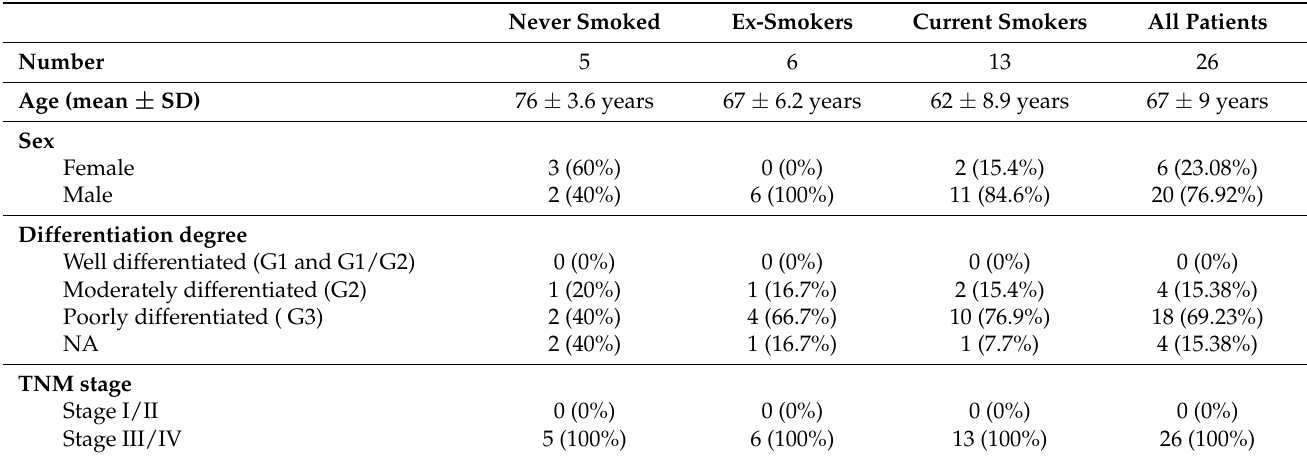
Table 2. Description of NSCLC patients’ analysis